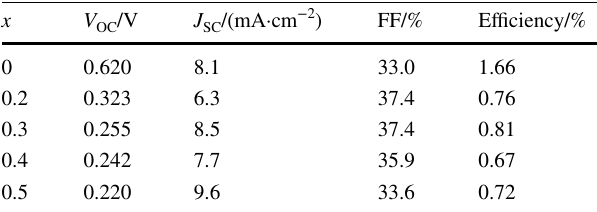
Device performance parameters of ZnO/Se 1− x Te x ( x = 0.2, 0.3, 0.4, 0.5) solar cells